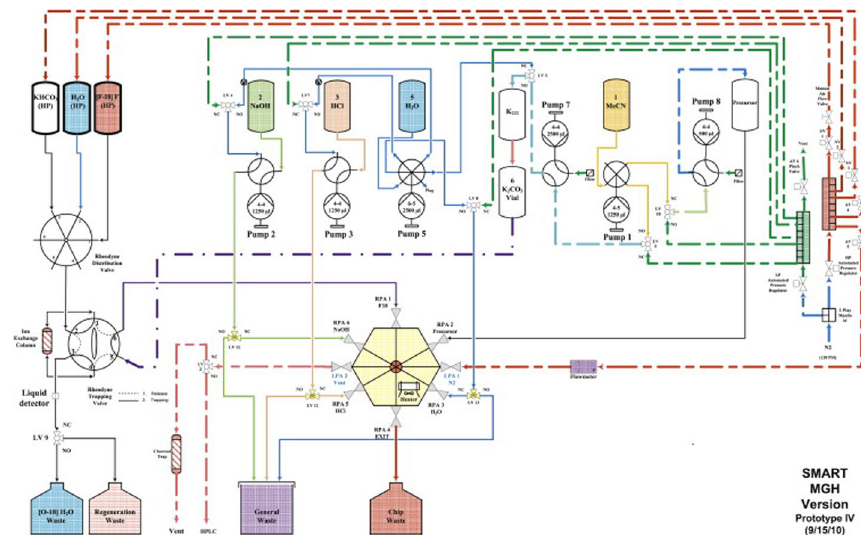
Fig. 3 Flow chart of [ 18 F]FMISO microfluidic radiochemistry (Yokell et al.